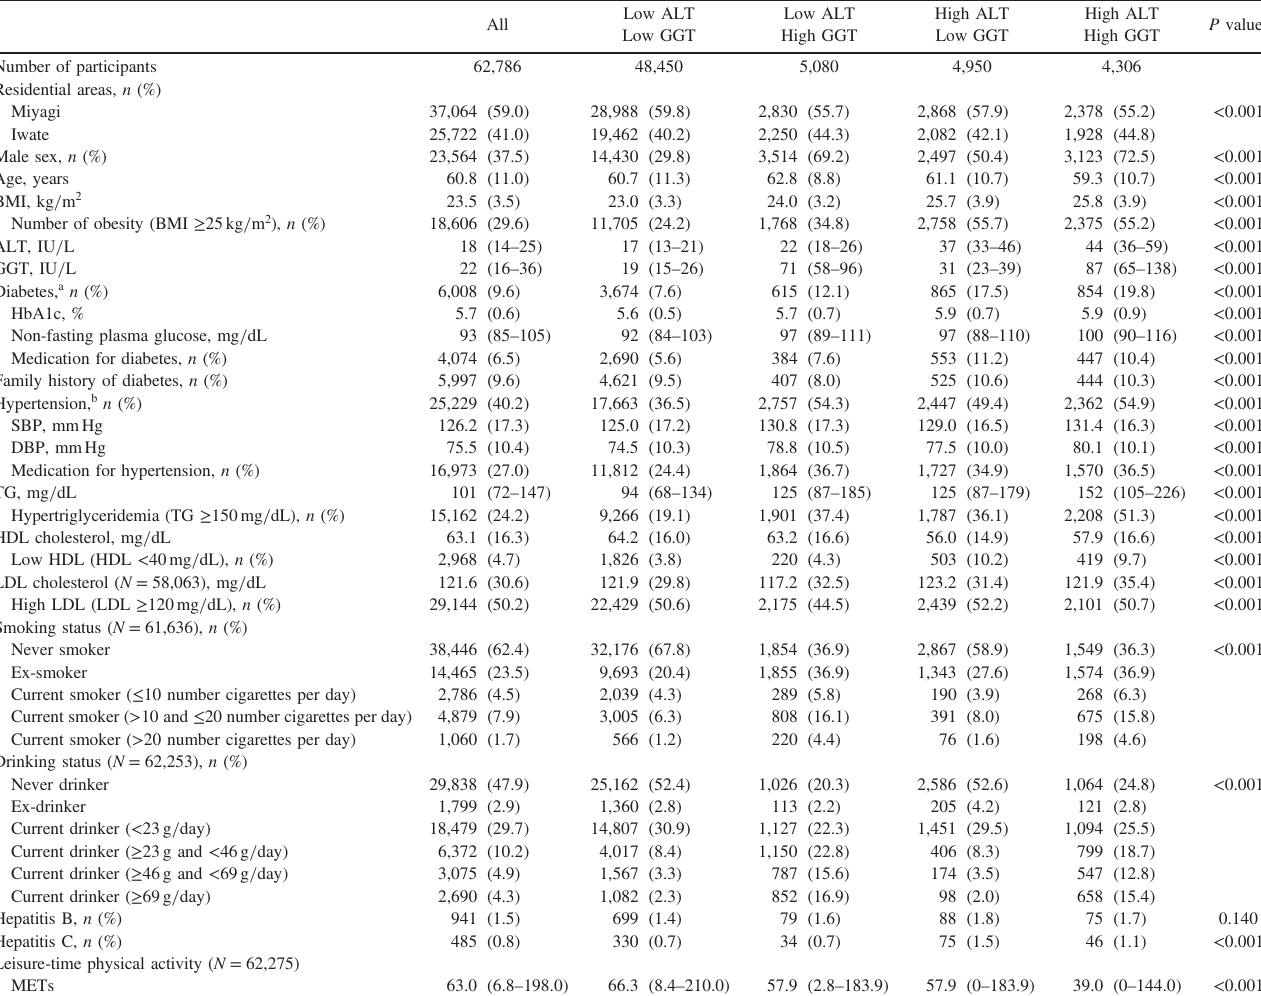
Table 1. The baseline characteristics of all participants according to the combination of ALT and GGT levels